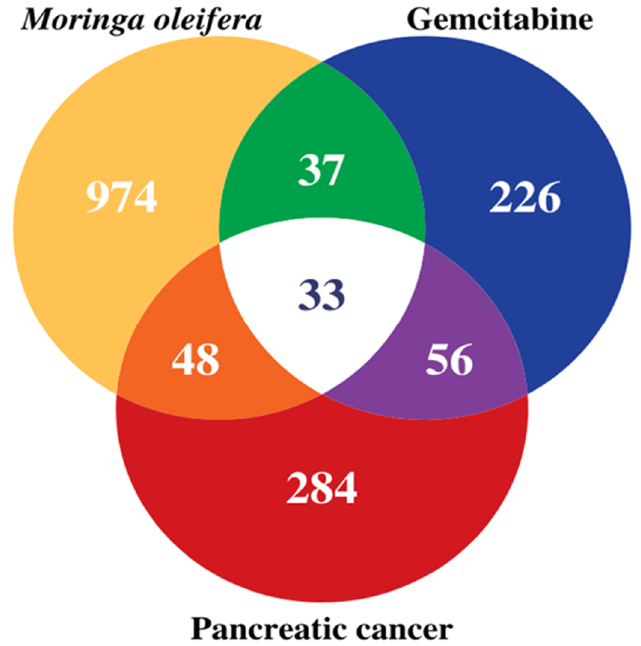
Figure 1. The relation of target genes via Venn diagram between 7 compounds of MO and GEM against pancreatic cancer. There are 137 target genes in MO + GEM intersection (orange, white, and purple) against pancreatic cancer. Biotargets that are shared by MO and GEM against pancreatic cancer are 33 (white) in total. MO and GEM intersections have 81 (orange and white) and 89 (purple and white) target genes against pancreatic cancer, respectively.